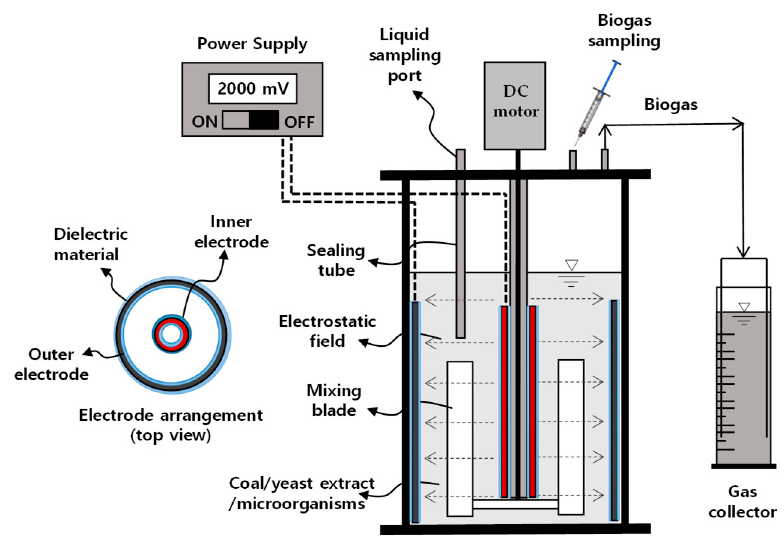
Figure 1. Schematic diagram of the bioelectrochemical anaerobic batch reactor for the conversion of coal to methane.